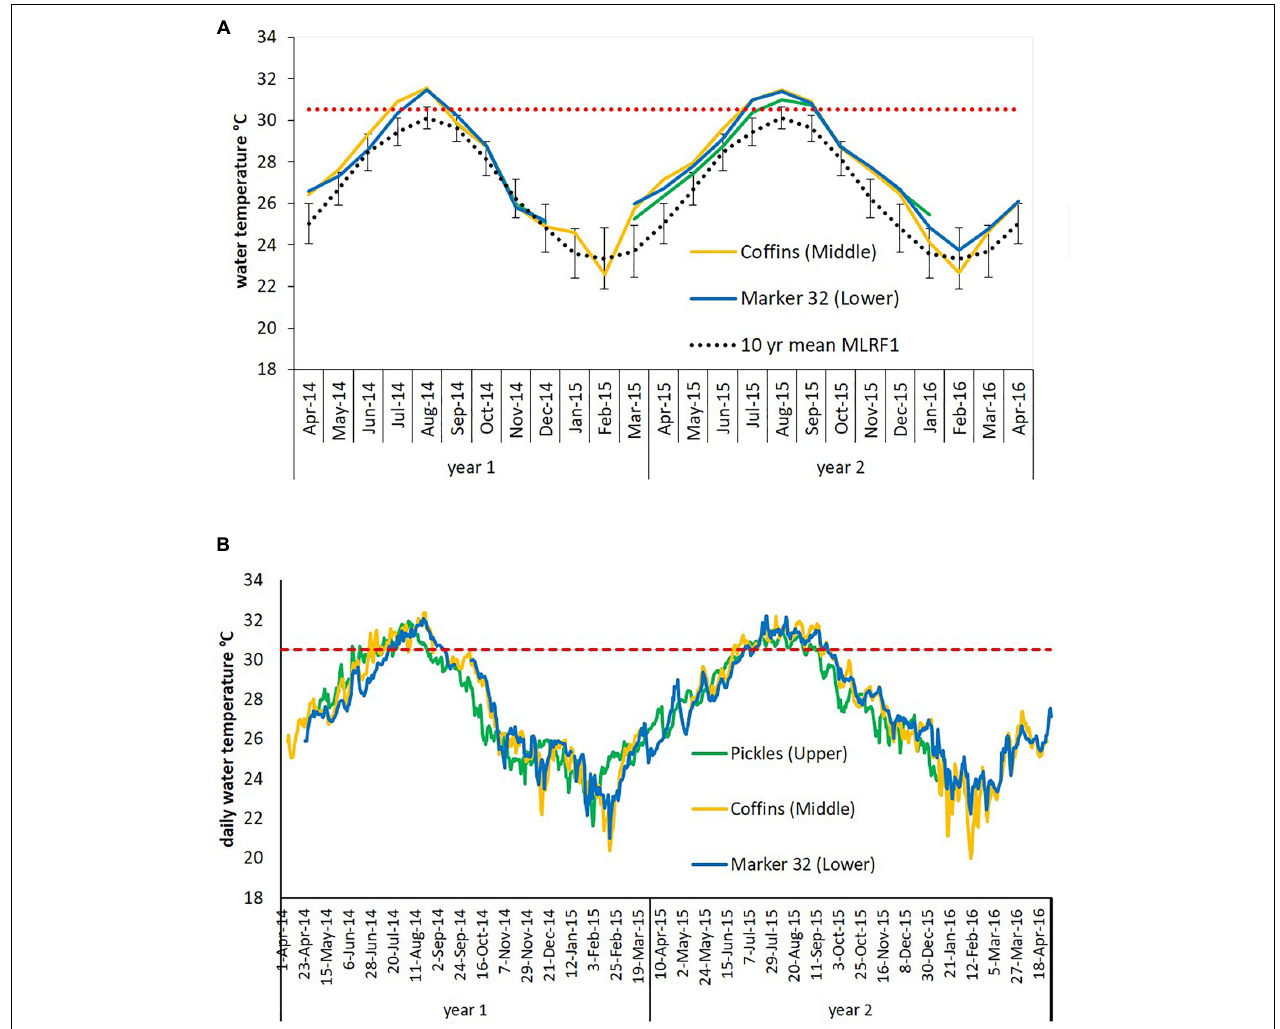
FIGURE 3 | Water temperatures at three sites in the Florida Keys recorded between April 2014 and April 2016. The Florida Reef Tract (FRT) in the Florida Keys is divided into distinct regions based on hydrologic influences, represented here by three sites: Pickles, Upper Keys; Coffins, Middle Keys; and Marker 32, Lower Keys. Red dashed lines indicate the local bleaching threshold for the FRT (30.5 ◦ C). Gaps in data are due to lost or damaged temperature loggers. (A) Mean monthly water temperature data. Dotted black line is the calculated 10-year mean monthly water temperature (error bars +1 SD) for Molasses Reef 2004-2013 (MLRF1, National Data Buoy Center). (B) Mean daily water temperature